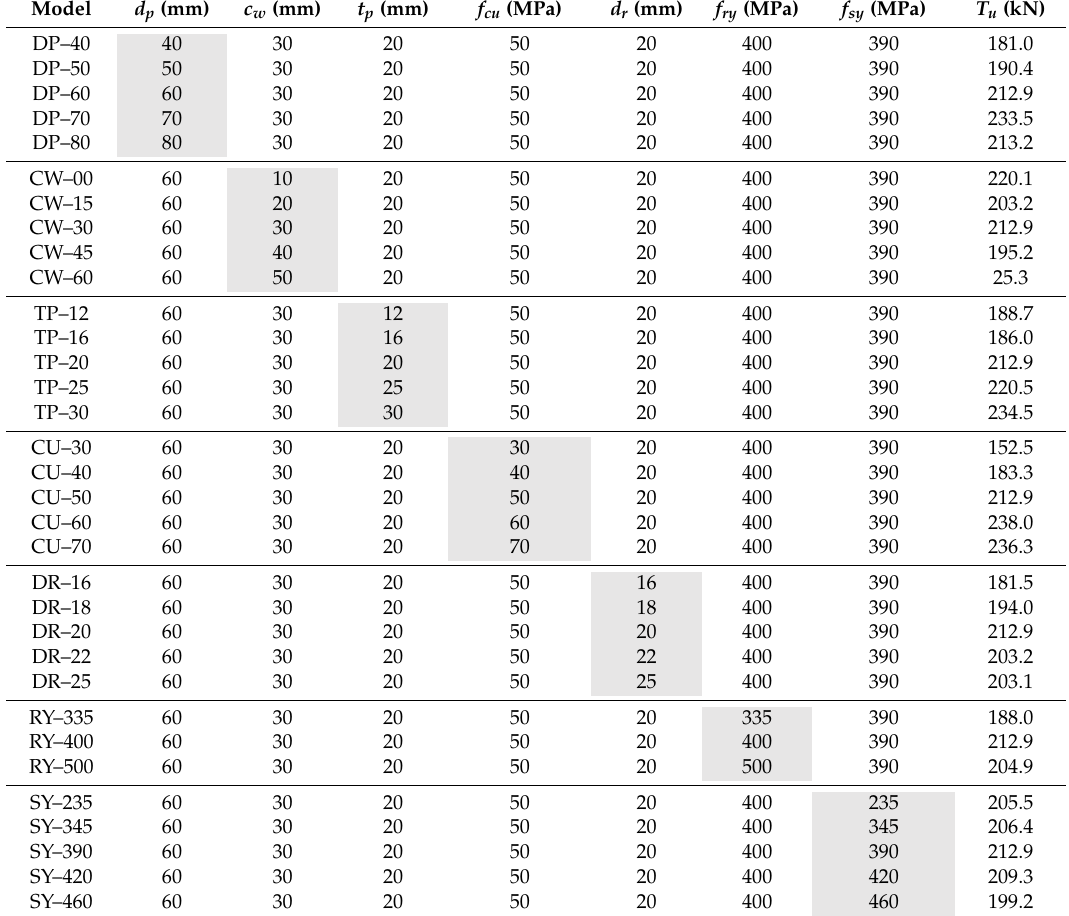
Table 3. Generalization of parametric models.